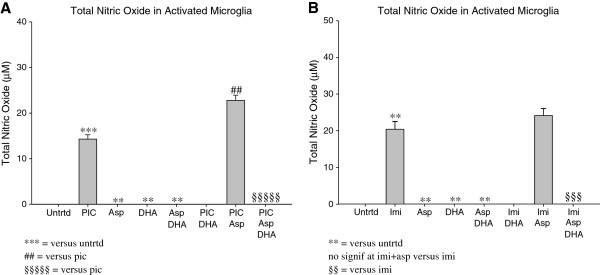
A. 50,000 EOC20 Microglia were plated in a 96 well plate containing Complete Medium plus 20% LADMAC Conditioned Medium. Cells were stimulated with 50μΜ aspirin or a combination of aspirin and Poly I:C. At 24 hours post Poly I:C and/or asprin treatment, supernatants were collected; total incubation time was 48 hrs. Supernatants were assayed for total Nitric Oxide using a total Nitric Oxide kit. Values were normalized to the untreated. Untrtrd=Untreated; PIC=Poly I:C (1μg/mL); Asp = Aspirin (1mM); DHA = Docosahexaenoic Acid (50μM). **, ## = p<0.005; *** = p<0.0005; §§§§§ = p<0.00005. B. 50,000 EOC20 Microglia were plated in a 96 well plate containing Complete Medium plus 20% LADMAC Conditioned Medium. Cells were stimulated with 50μM DHA for 24 hours. After 24 hours, cells were stimulated with Imiquimod, 1mM Aspirin, or a combination of Imiquimod and Aspirin. At 24 hours post Imiquimod and/or Aspirin treatment, supernatants were collected; total incubation time was 48 hours. Supernatants were assayed for total Nitric Oxide content using a total Nitric Oxide kit. Values were normalized to the untreated. Untrtd = Untreated; Imi = Imiquimod (10μg/mL); Asp = Aspirin (1mM); DHA = Docosahexaenoic Acid (50μM). ** = p<0.005; §§§ = p<0.0005.